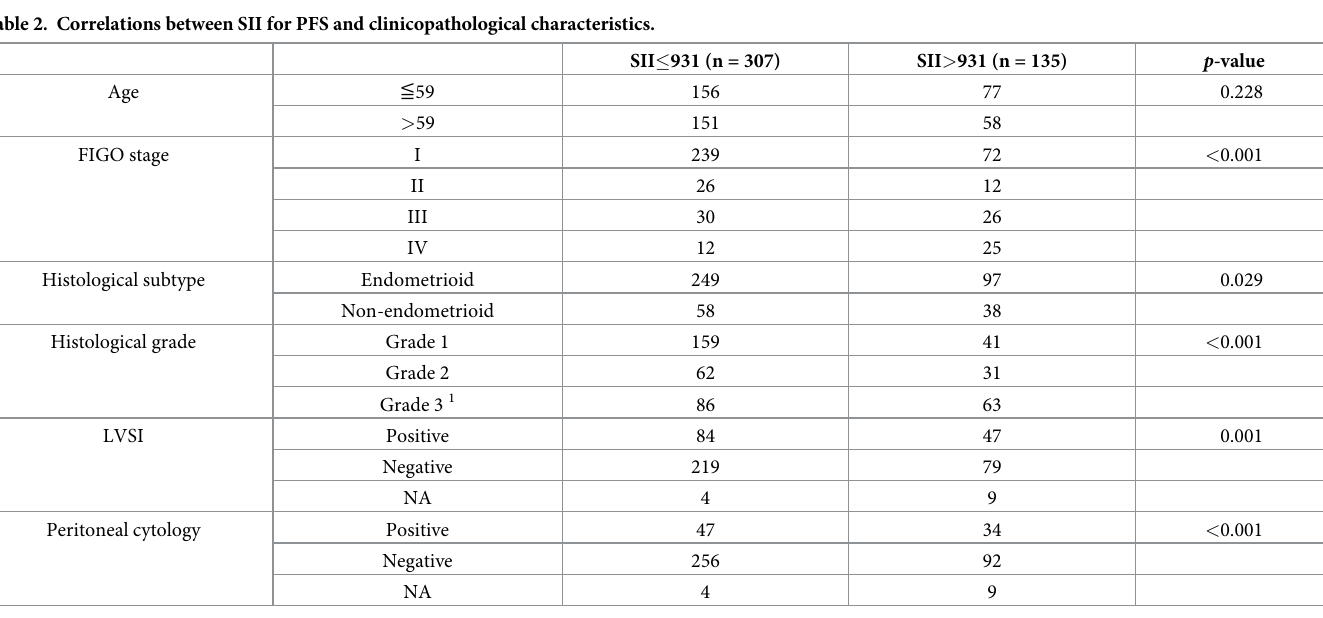
Table 2. Correlations between SII for PFS and clinicopathological